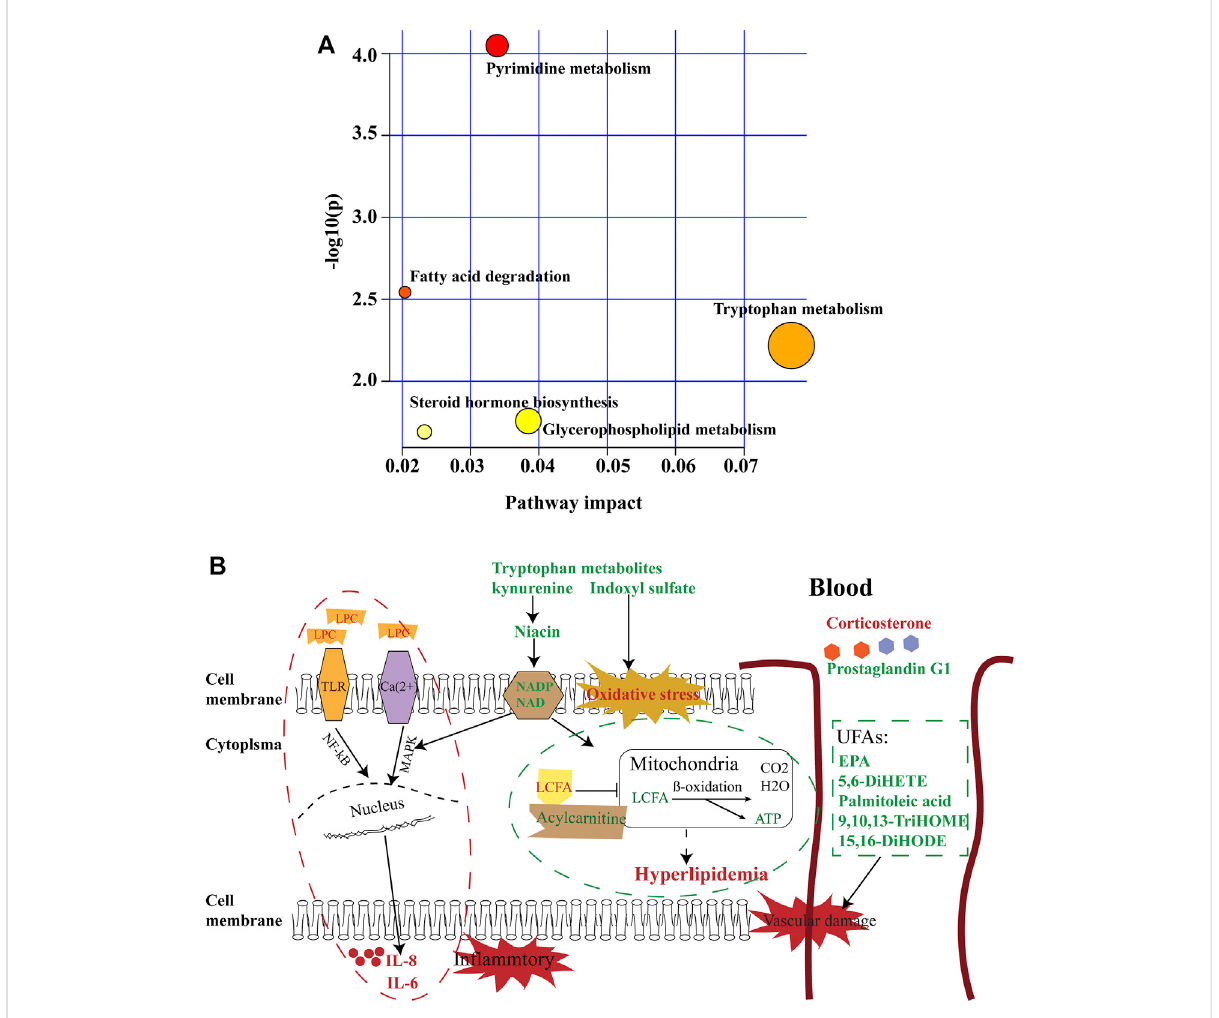
FIGURE 5 Summary of pathway analysis. (A) Pathways of metabolic abnormalities caused by HUA. Pathway impact value calculated from pathway topology analysis; a small p -value and large pathway impact factor indicate the pathway was signi fi cantly affected. (B) Diagram of abnormal metabolic pathways in rats with HUA. Red color indicates increased metabolites, green color indicates decreased